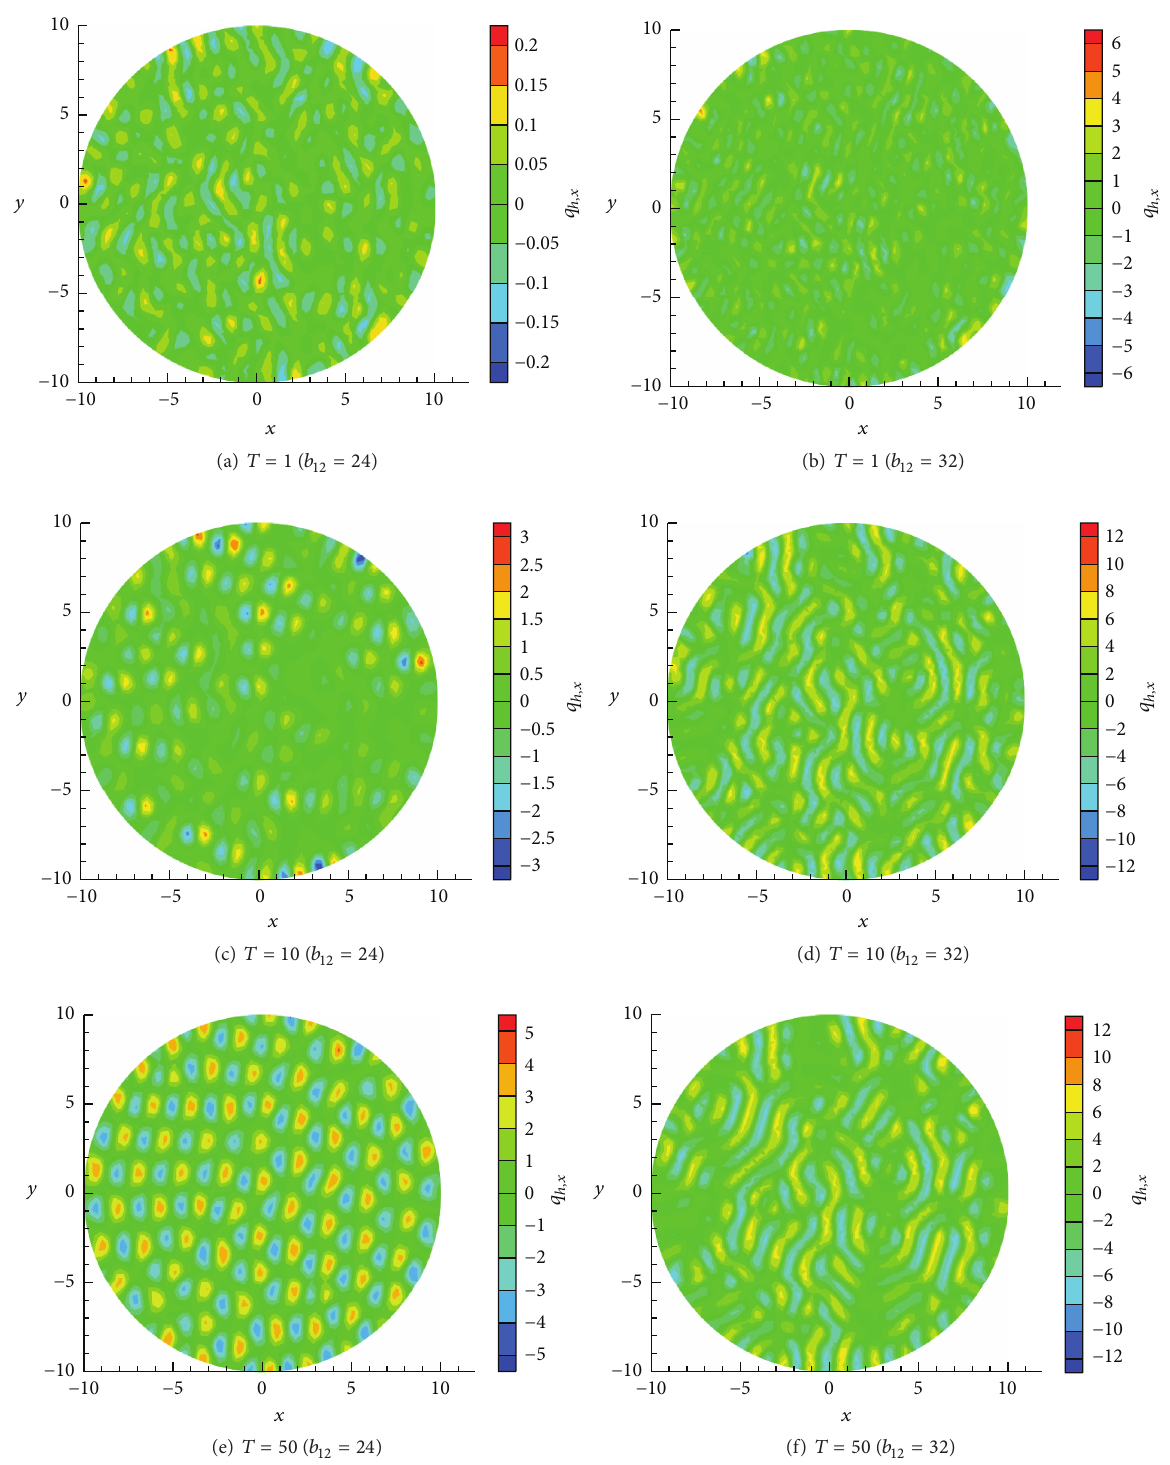
Figure 10: Graphs of 𝑥 -direction component of q ℎ for 𝑏 12 = 24 (left) and 𝑏 12 = 32 (right) on the circular